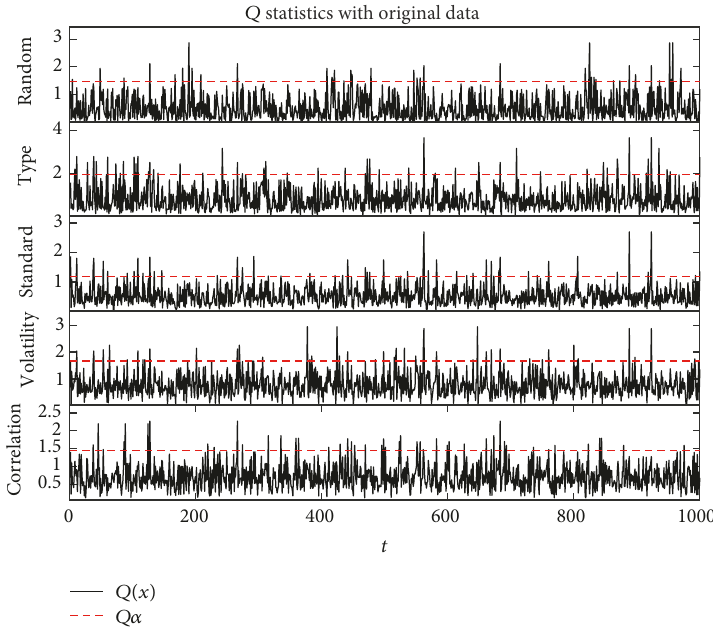
Figure 5: 𝑄 statistics with original data in 5 PCA